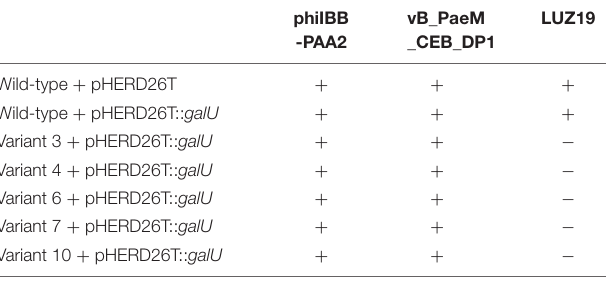
TABLE 3 | Susceptibility of the P. aeruginosa PAO1 wild-type and phage-resistant variant strains (3, 4, 6, 7, and 10) complemented with galU gene to the